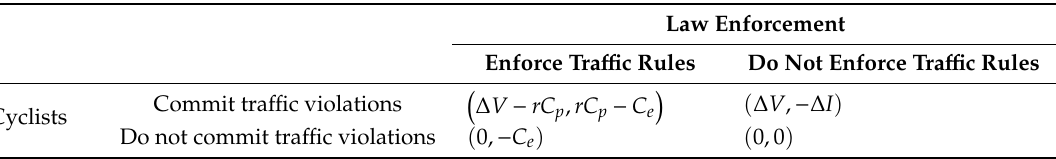
Table 1. Payo ff matrix for cyclists and law